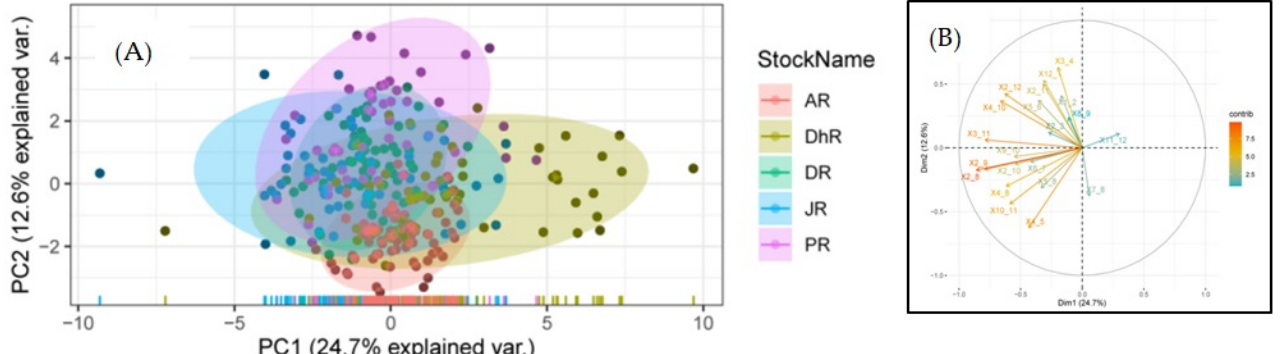
Figure 6. Principal component analysis (PCA) of truss measurements of Botia dario stocks obtained from five rivers of Bangladesh. ( A ) Bi-plots of principal component analysis are shown and ( B ) di- mension results represent the loadings of each